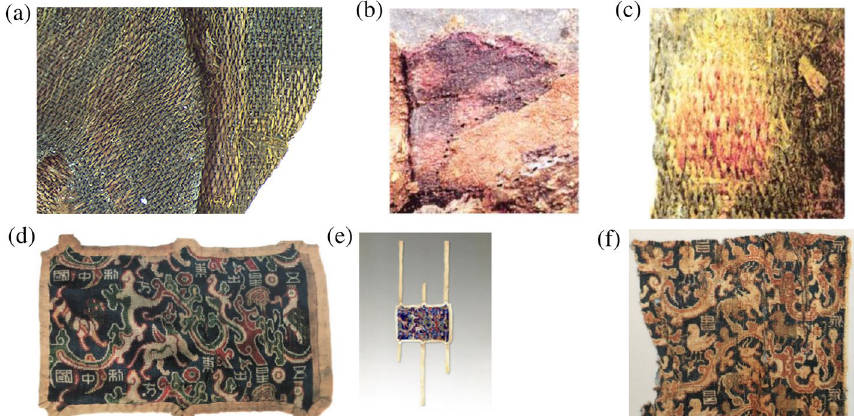
Fig. 1 Dark background KyungGeum brocade with the pattern by the colored multiple warps in delicate outlines. a Dark blue green KyungGeum from the Miruksaji temple of Baekje (639) (Kim et al., 2021). b Dark KyungGeum with pink flowers from Cheon‑Ma‑Chong of Silla (514) (Jang & Kwon, 2014). c Close‑up of pink flowers (Jang & Kwon, 2014). d ‘O‑Seong‑Chul‑Dong‑Bang’ KyungGeum of arm protector from Niya ( 尼雅 ), Xinjiang Autonomous Region shows animal flocks and puffy clouds (BC third–fifth century). This close‑up shows the pattern of old letters of prayer and 2 stars, crane and eagle, a heavenly animal and a tiger (Huang & Chen, 2016). e Whole view of the arm protector with 6 GoRum straps of MyungJu silk (Huang & Chen, 2016). f Saekdong YoungChang ( 永昌 ) KyungGeum from Louran, Xinjiang Autonomous Region: three‑legged crow ( 三 足烏 ) and heavenly animal flocks of dotted skin, the letterings of prayer (Huang & Chen, 2016) (All photos are with permission from the copyright